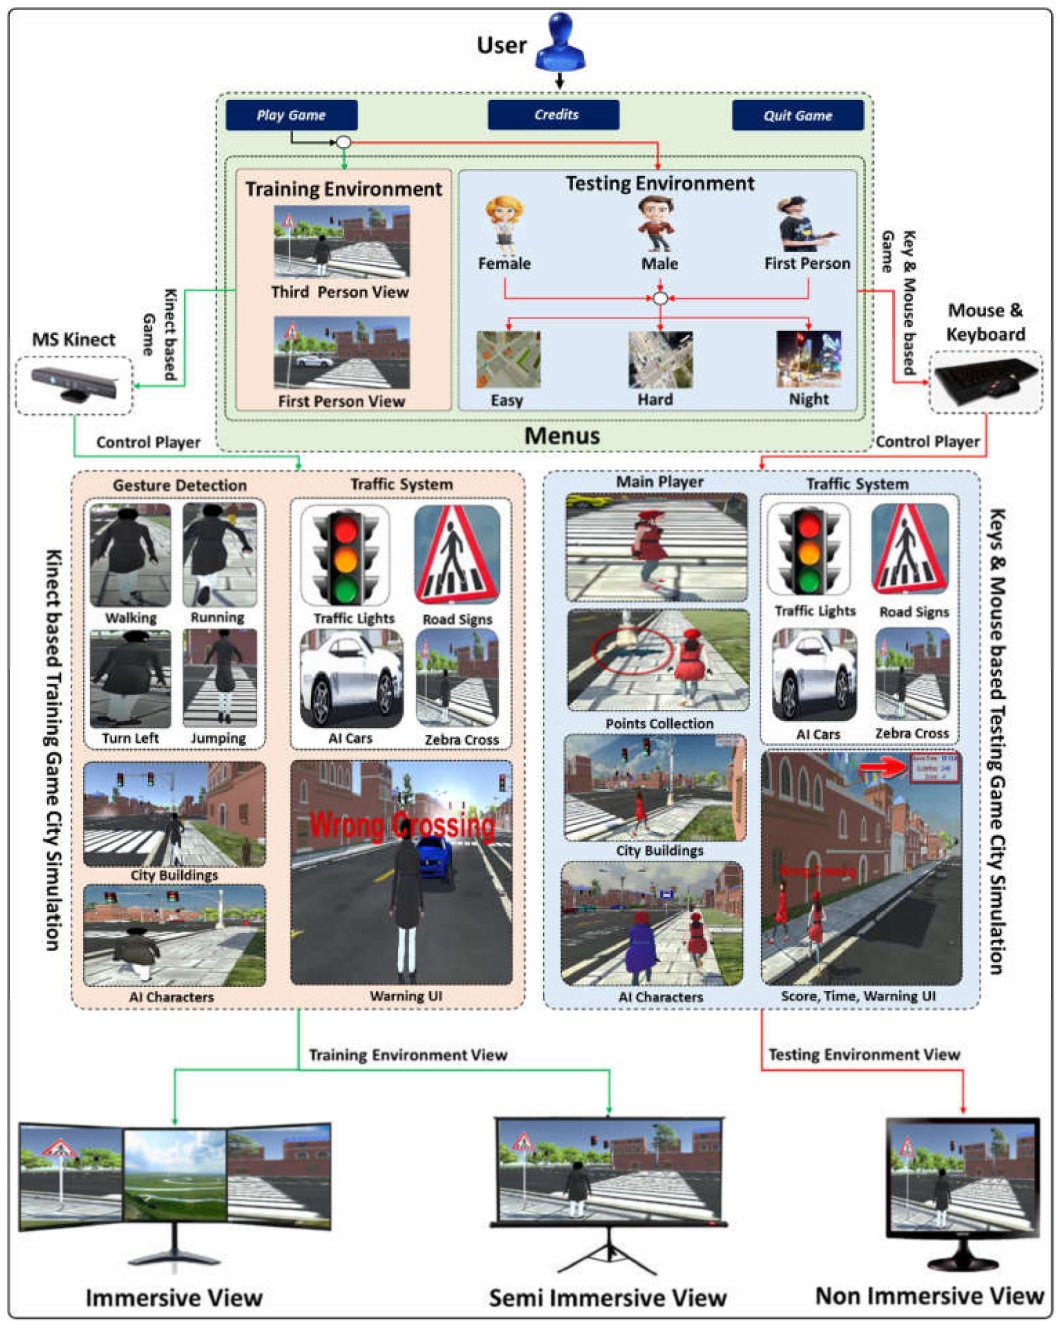
Figure 3. There is a training and a testing environment in the output screen of our application and a user can choose anyone of them. The training environment uses Kinect as the input device and the testing environment has a keyboard and mouse for interaction. The proposed system supports different hardware setups, varying in degree of immersion, availability, and